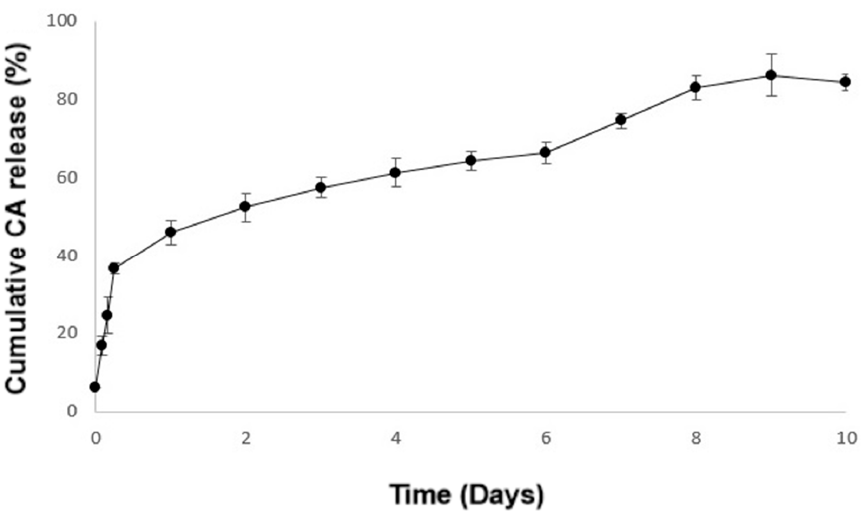
Figure 5. Cumulative release profile of the crude CA extract from the bottom’s PVA_CS-TPP nanofibers at pH = 5.5.